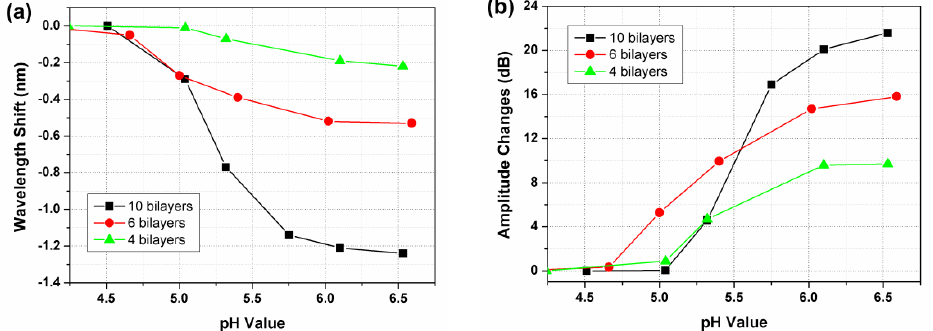
Figure 7. ( a ) Wavelength shift and ( b ) amplitude change of one resonance around 1,557 nm for three sensors with coatings having different numbers of bilayers (4, 6,